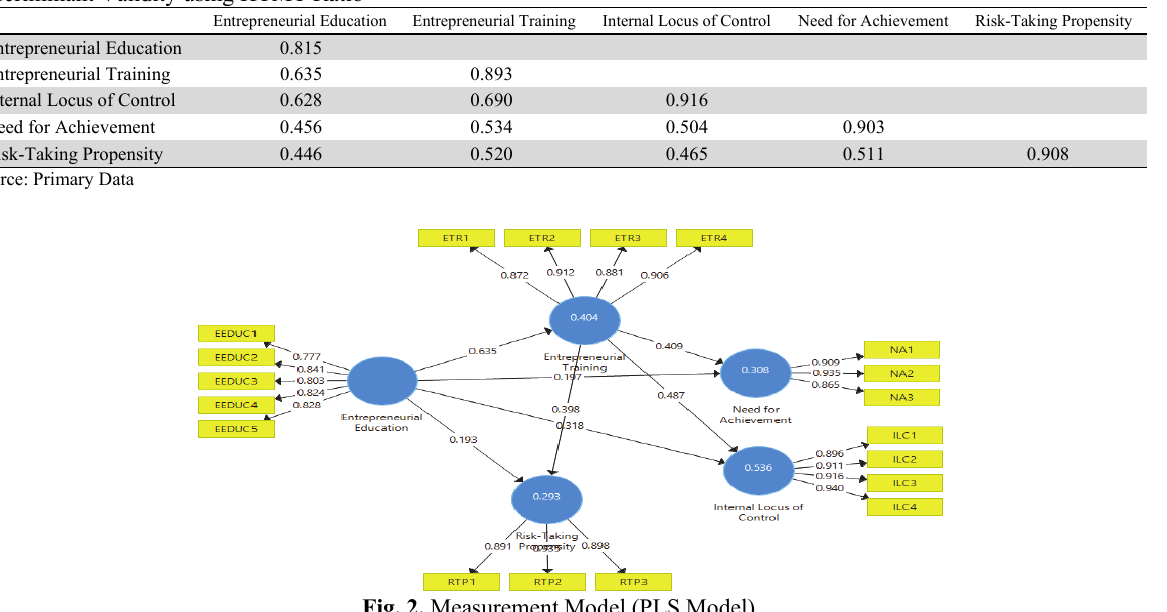
Evaluation of the Path